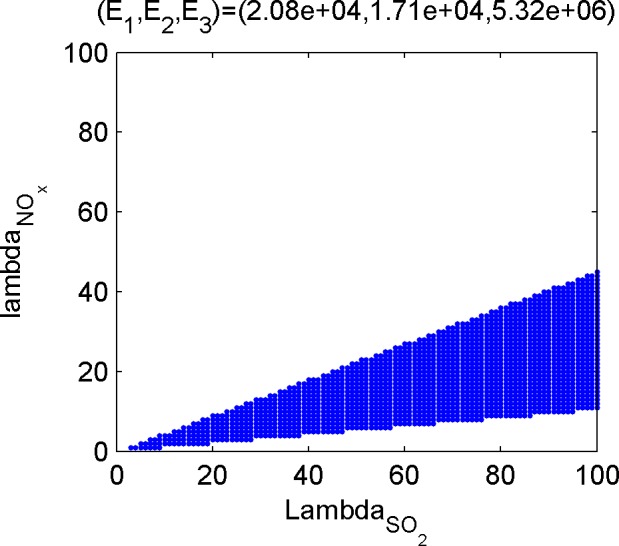
The dominant set relevant for (E1,E2,E3) = (2.08e+04,1.71e+04,5.32e+06).